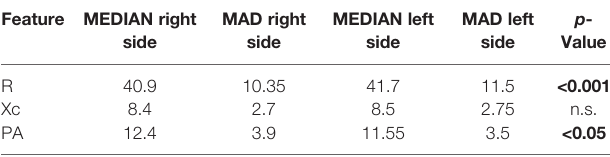
The last column shows the results of the Wilcoxon signed-rank test for paired data between the left and right sides of the prostate (n.s., nonsigni fi cant p-value). Bold values indicate signi fi cant p-values lower than